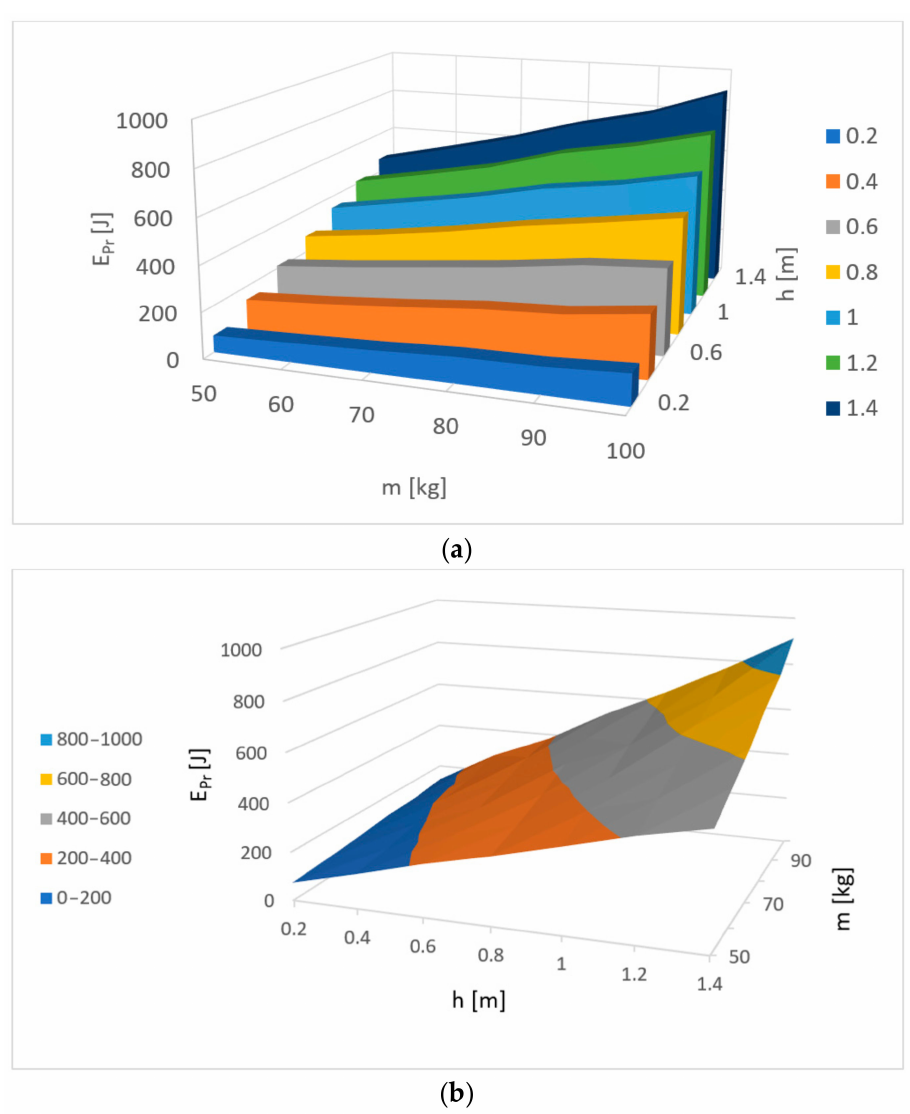
Figure 13. The correlation between the impact energy E Pr and the hammer mass m (the spherical impactor) for impact heights h in meters: ( a ) a 3D area chart; and ( b ) a surface